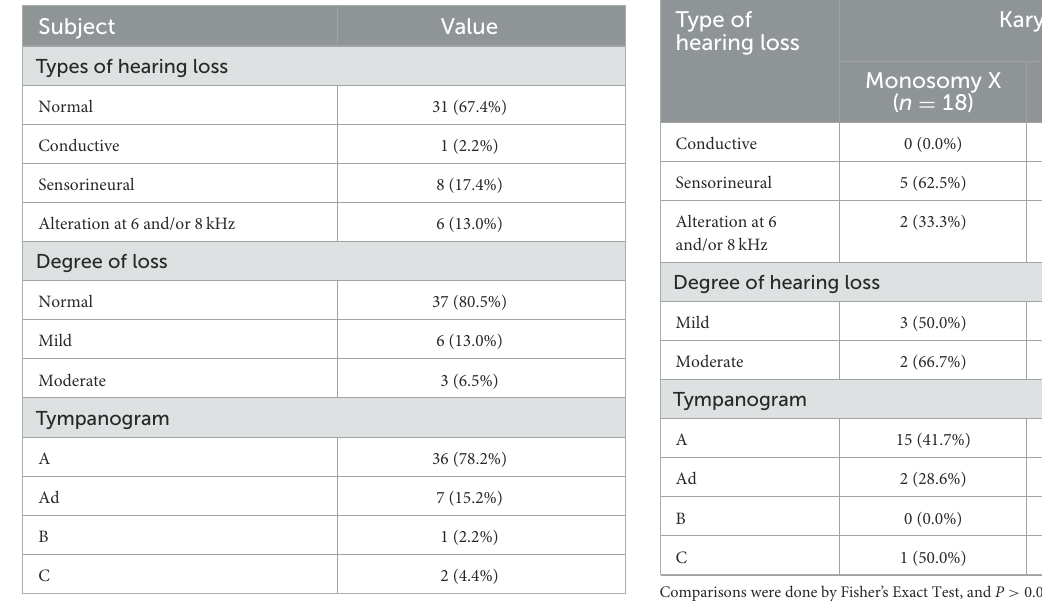
TABLE 2 Audiological tests for TS of the study.